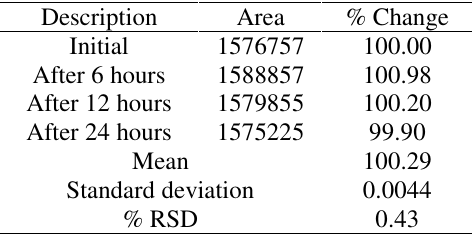
Table 5. Stability